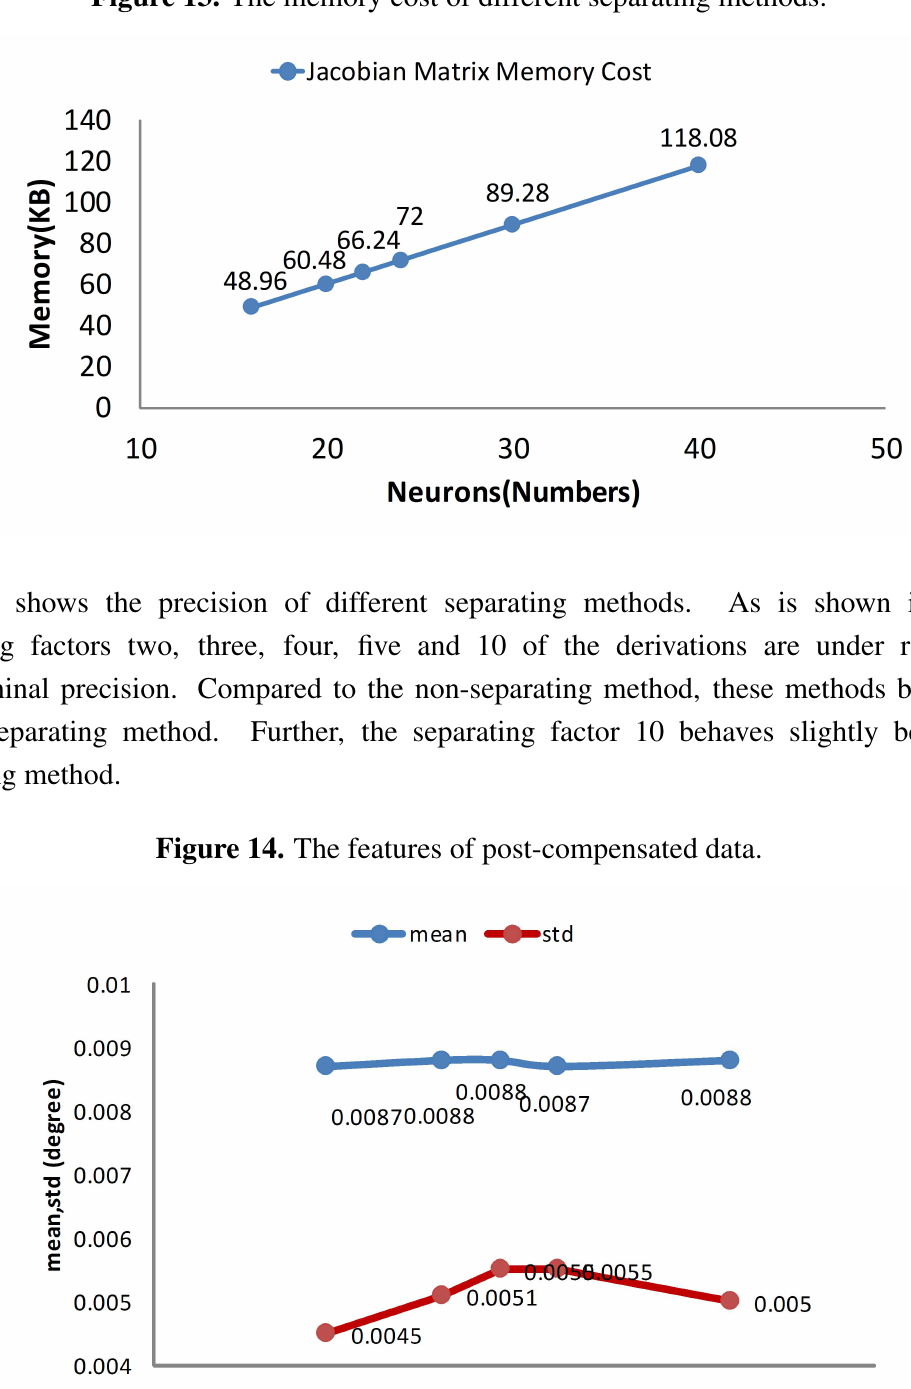
Figure 13. The memory cost of different separating methods.